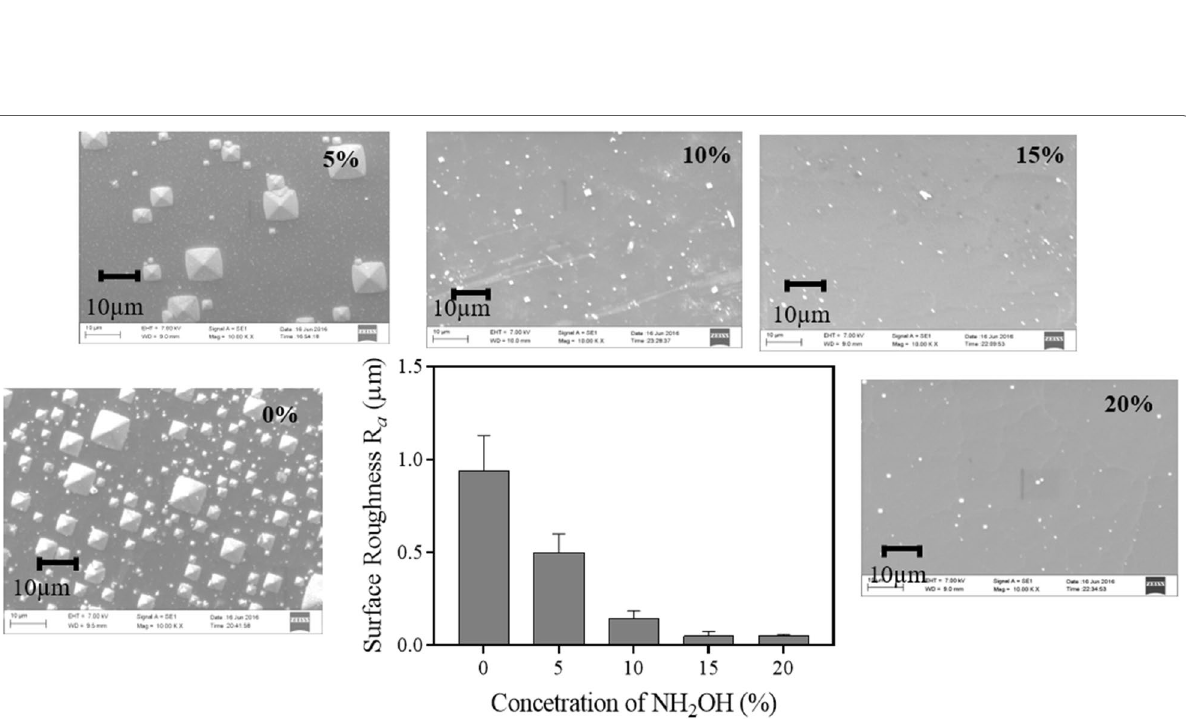
Fig. 39 Etched surface roughness (Ra) and corresponding surface morphologies of Si{100} in pure and different concentrations of NH 2 OH added 5 wt% TMAH at 70 1 °C ±